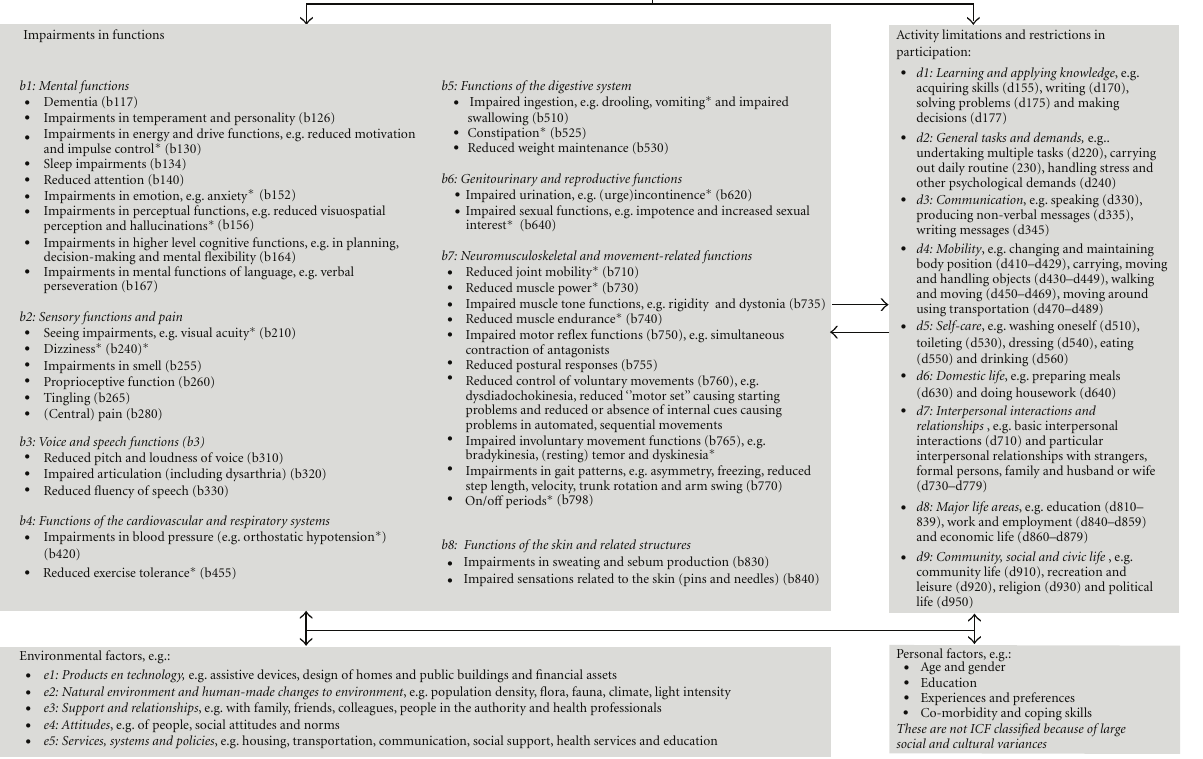
Figure 3: ICF model for Parkinson’s disease. ICF: International Classification of Functioning, Disability and Health; numbers, for example, b770, refer to codes in the ICF Handbook